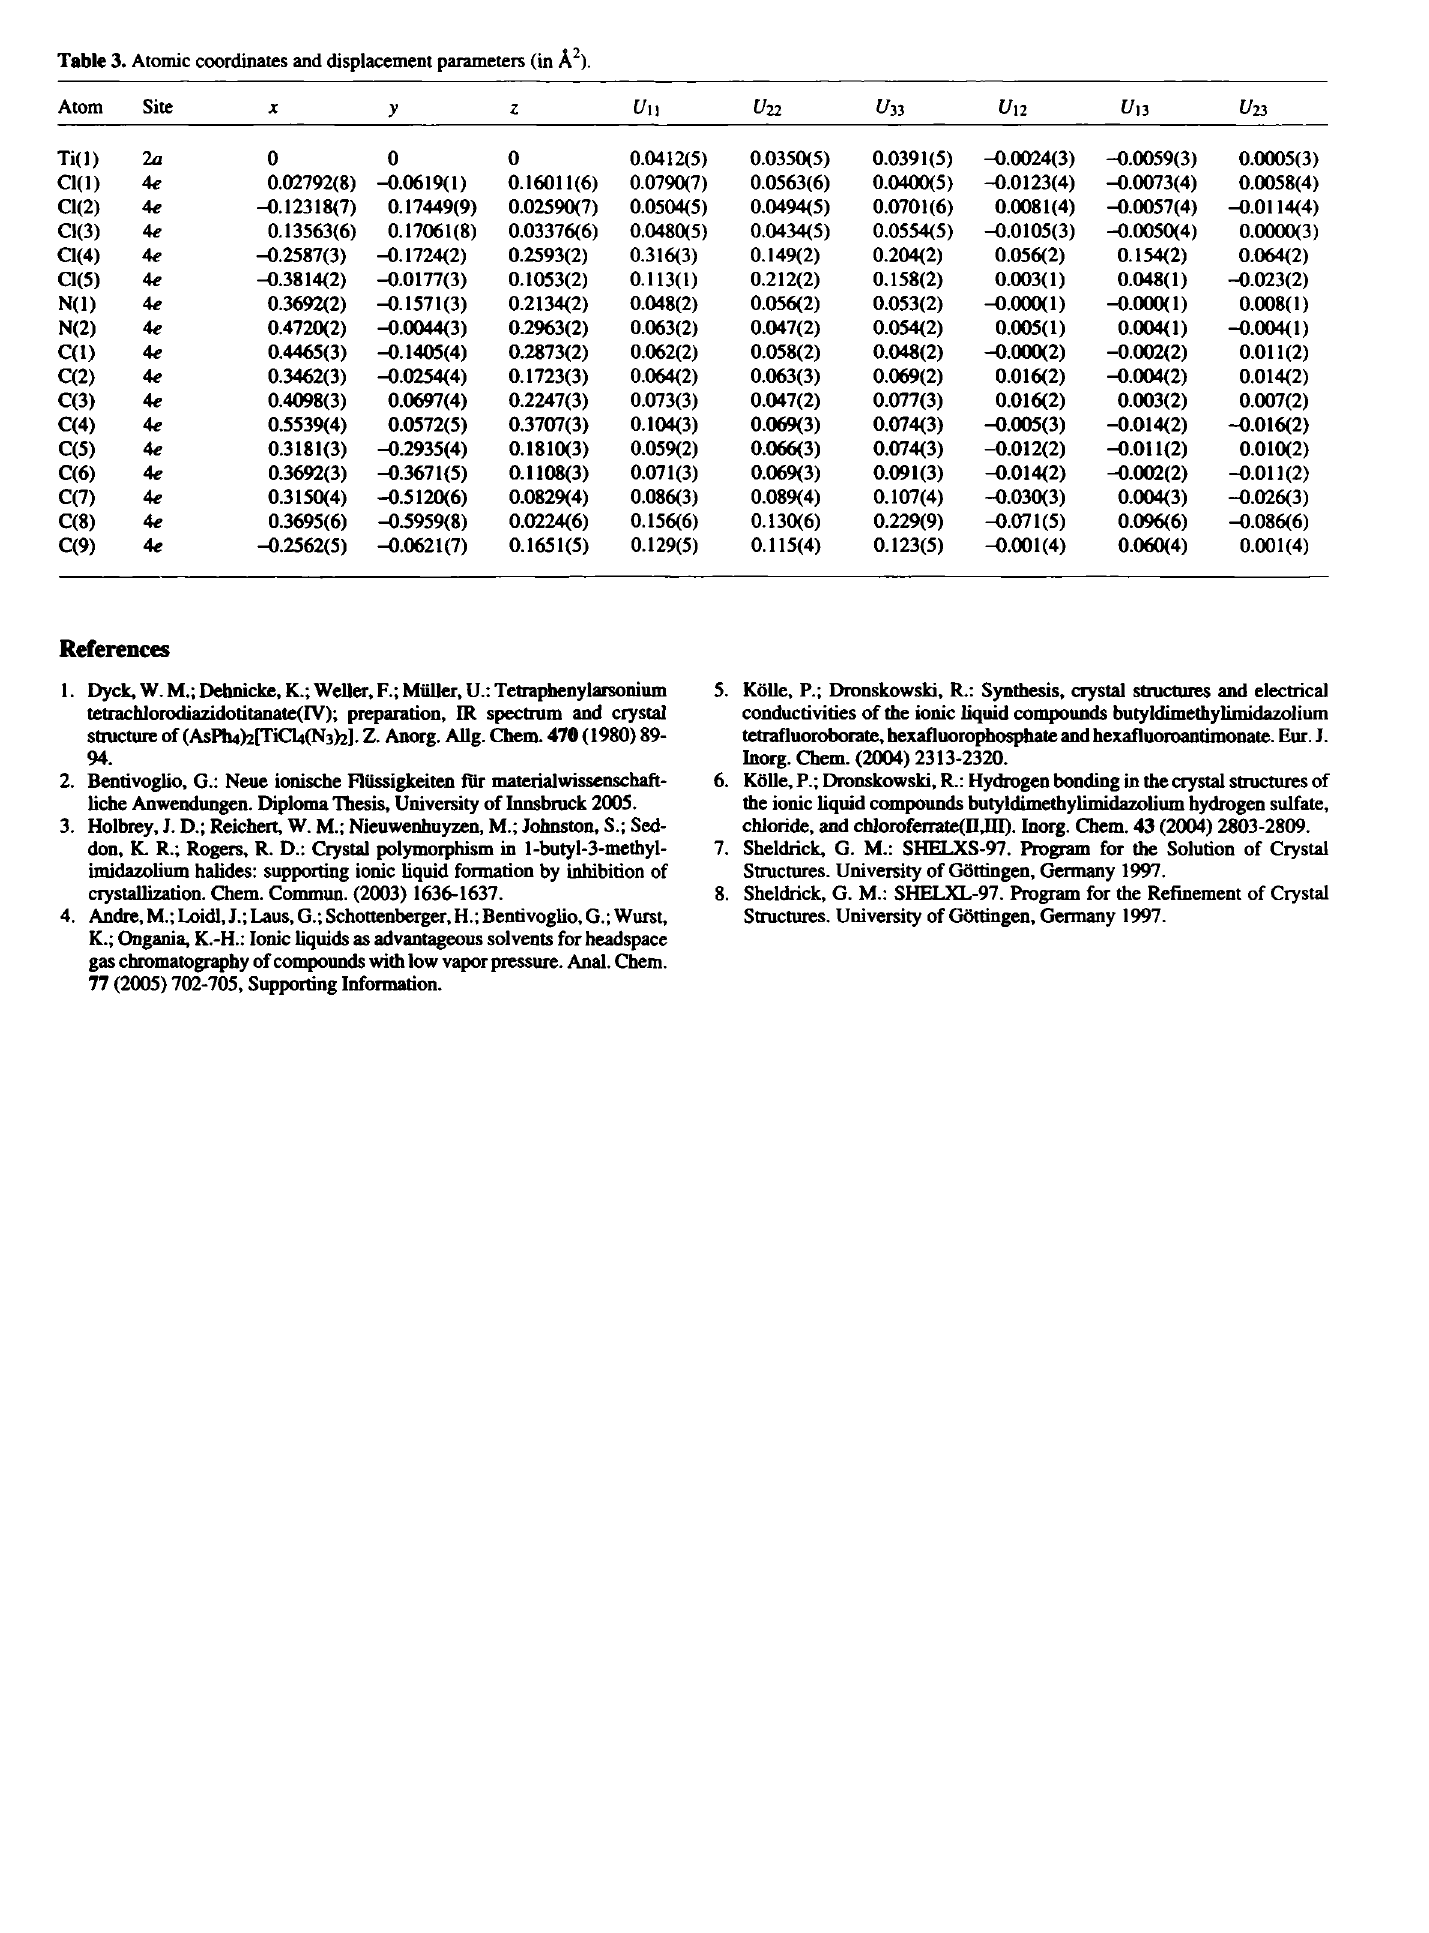
Table 3. Atomic coordinates and displacement parameters (in A 2